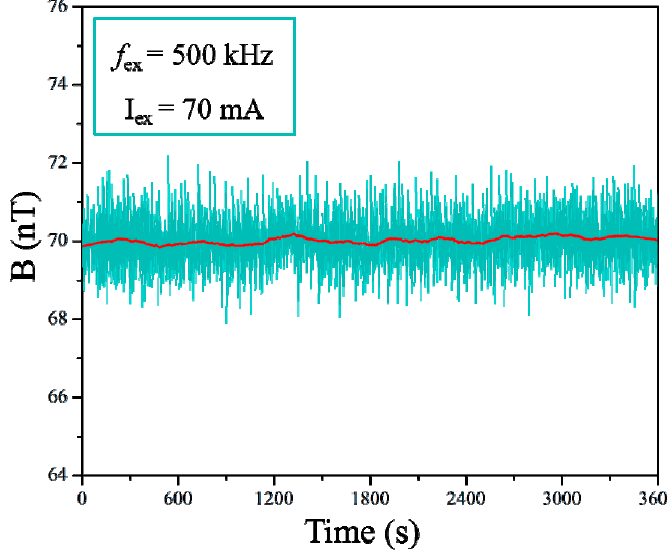
Figure 6. Offset drift of the sensor over 1 h.